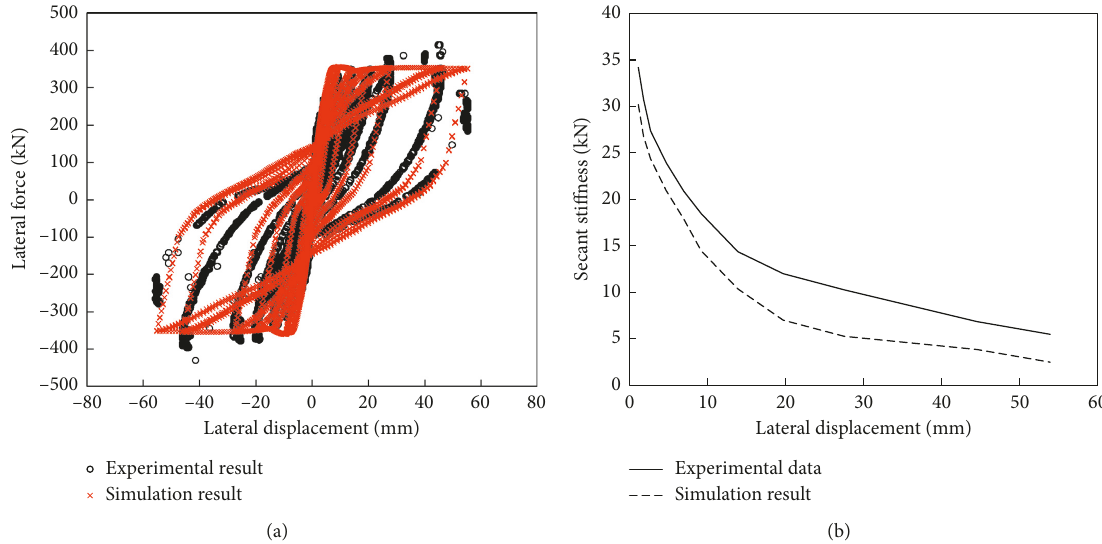
Figure 18: Comparison between simulation results and experiment results of GWF1: (a) hysteresis loop; (b) stiffness